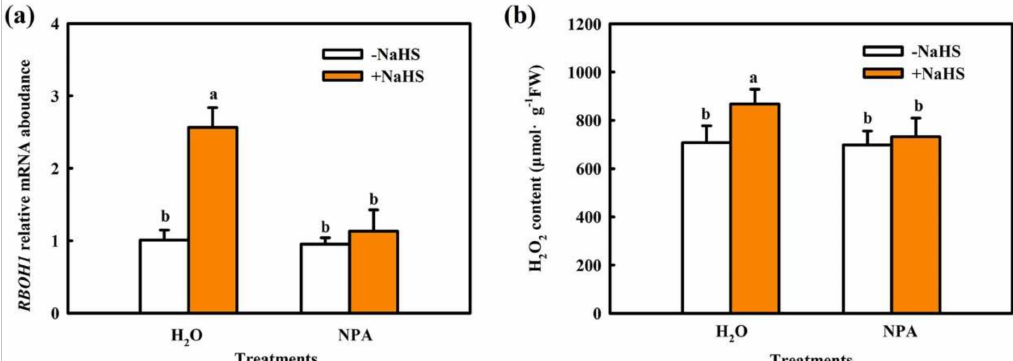
Figure 8. Effect of NPA on H 2 S-induced RBOH1 mRNA abundance ( a ) and H 2 O 2 accumulation ( b ) in cucumber seedlings. Cucumber seedlings were pretreated with 50 µ M NPA or deionized water and then sprayed with 1.0 mM NaHS after 6 h. Twelve hours later, the seedlings were exposed to 5 ◦ C for 9 h. The data represent the mean ± SD of three biological replicates. Different letters indicate significant differences ( p < 0.05), according to Duncan’s new multiple range test.